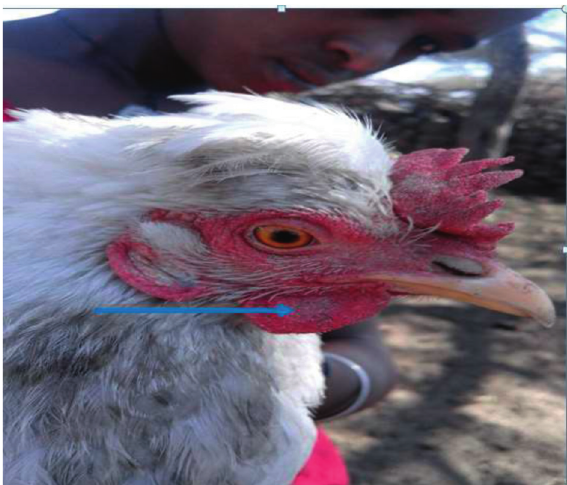
Figure 2: Firm erythematic nodular swelling on the right wattle of the avian intradermal tuberculin test positive chicken (indicated by an